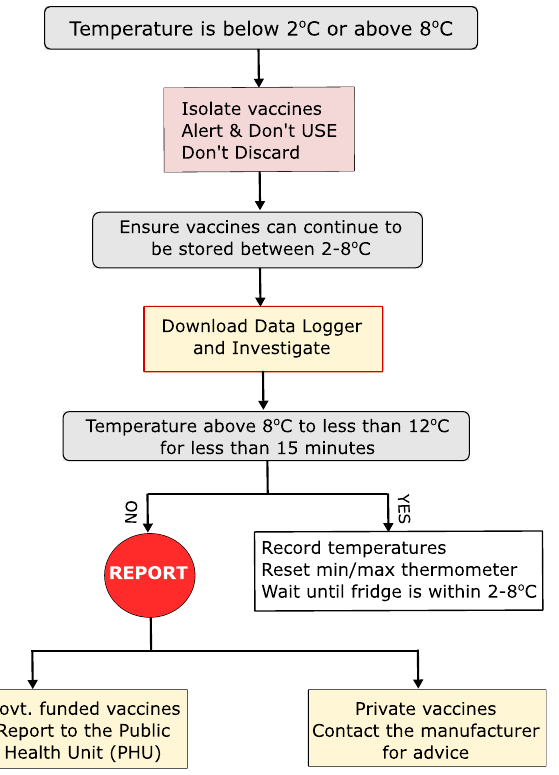
Figure 1. Managing a cold chain breach.